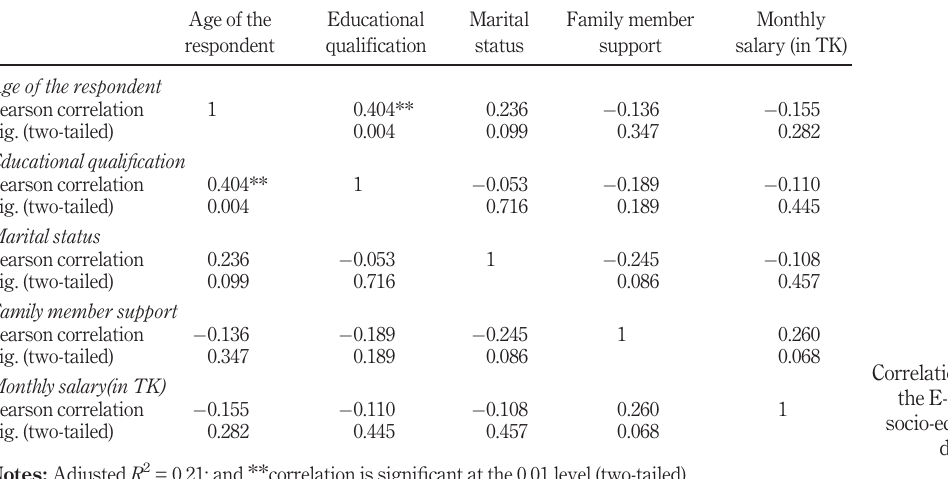
Table VII. Correlation matrix